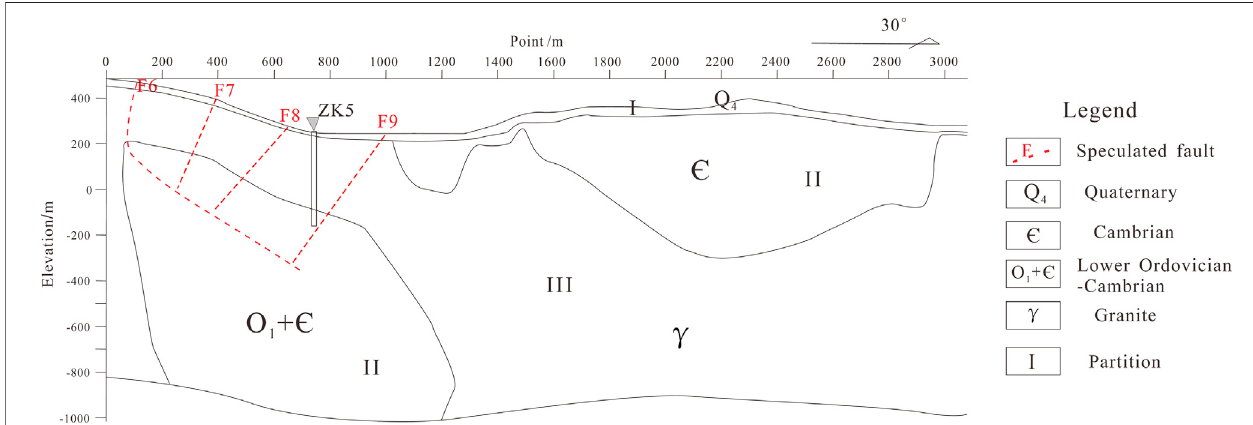
FIGURE 7 | CSAMT integrated interpretation section of survey line L1 and its